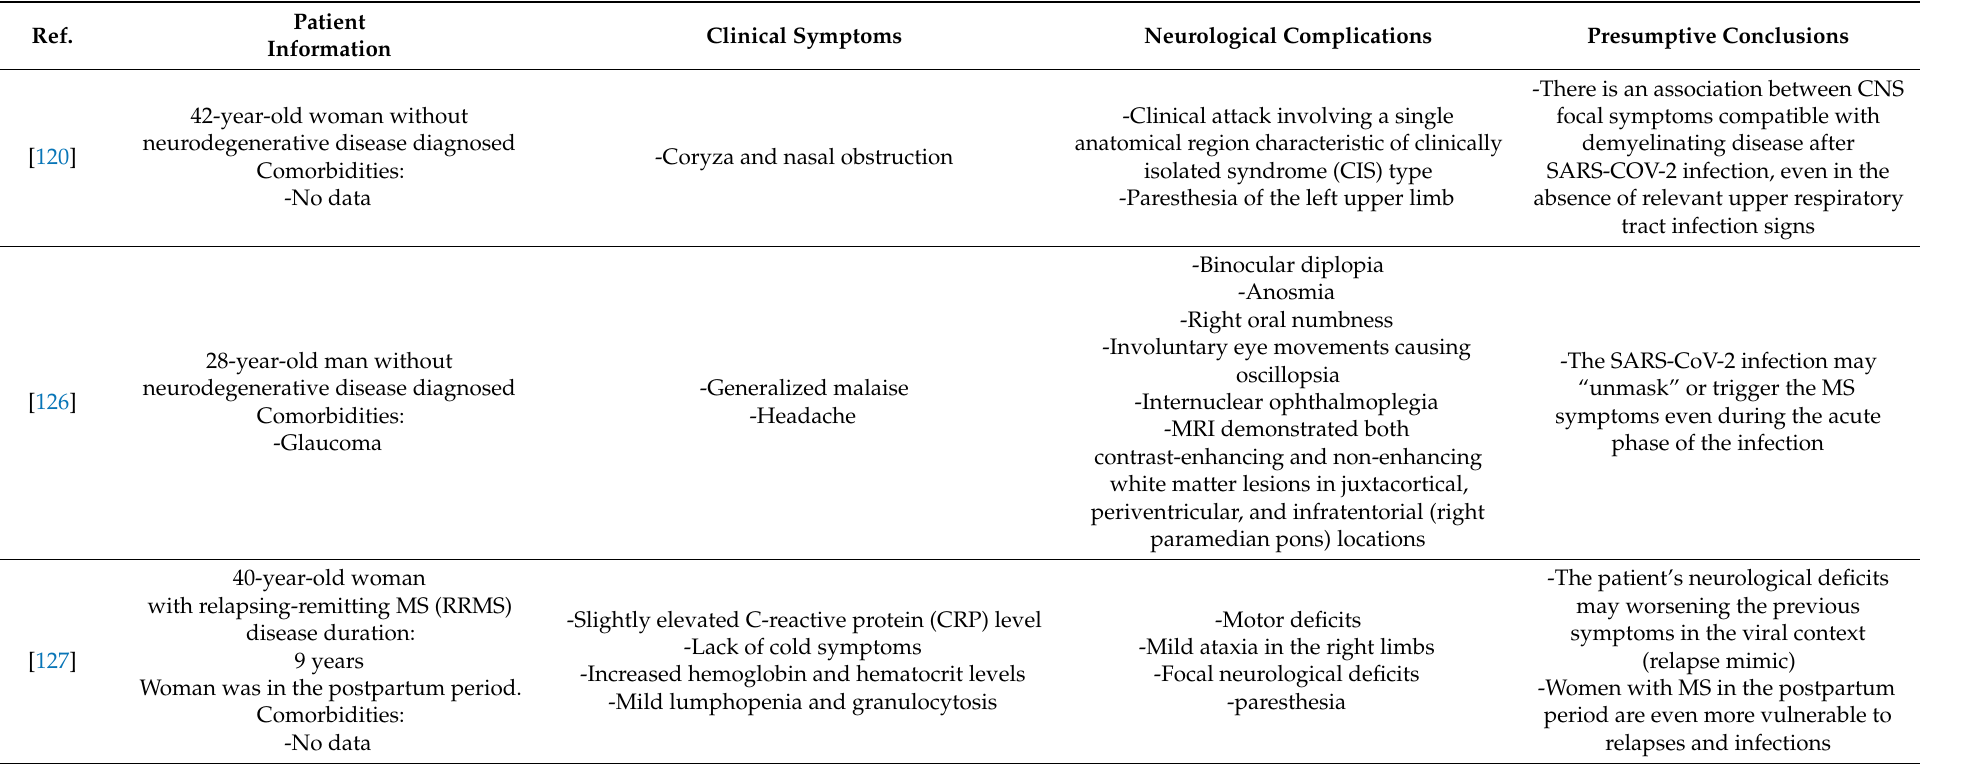
Table 1. Published case reports of people after SARS-CoV-2 infection and their clinical symptoms and neurological complications.